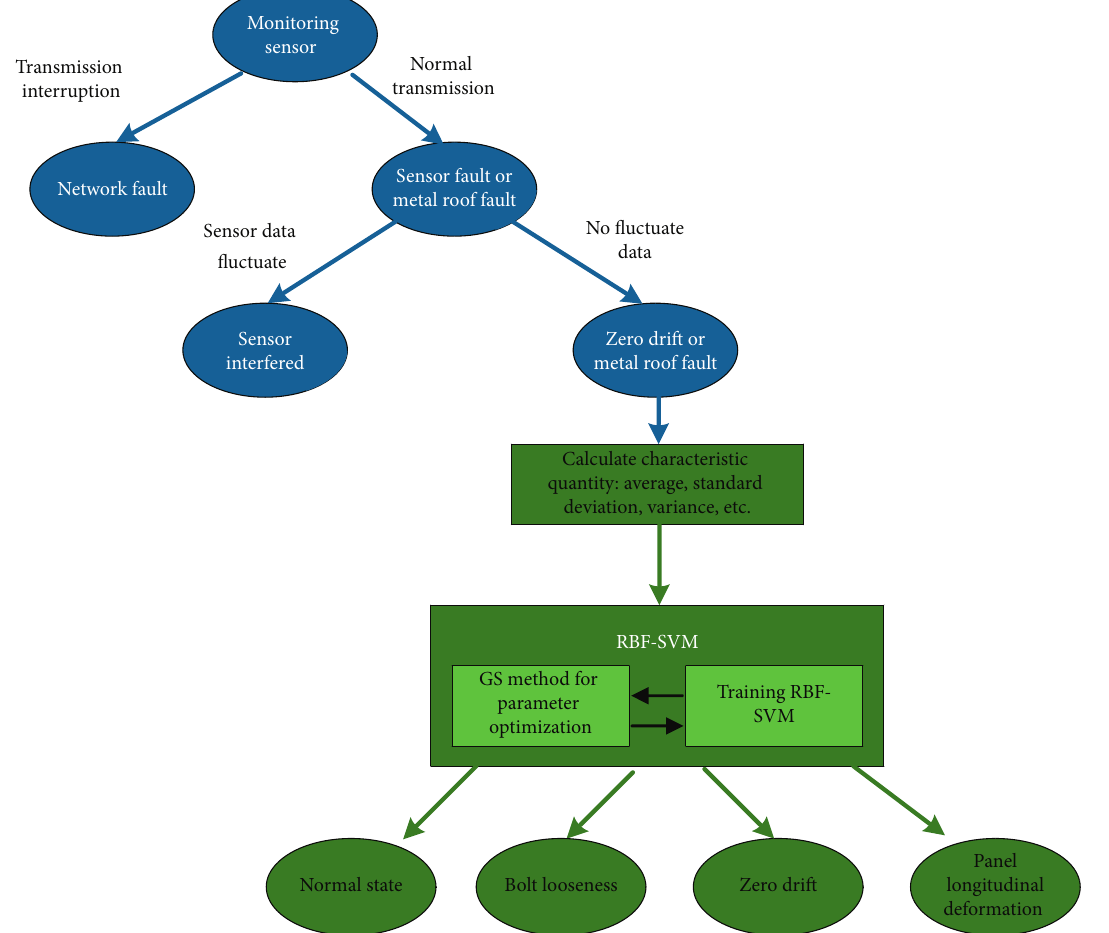
Figure 6: Fault diagnosis